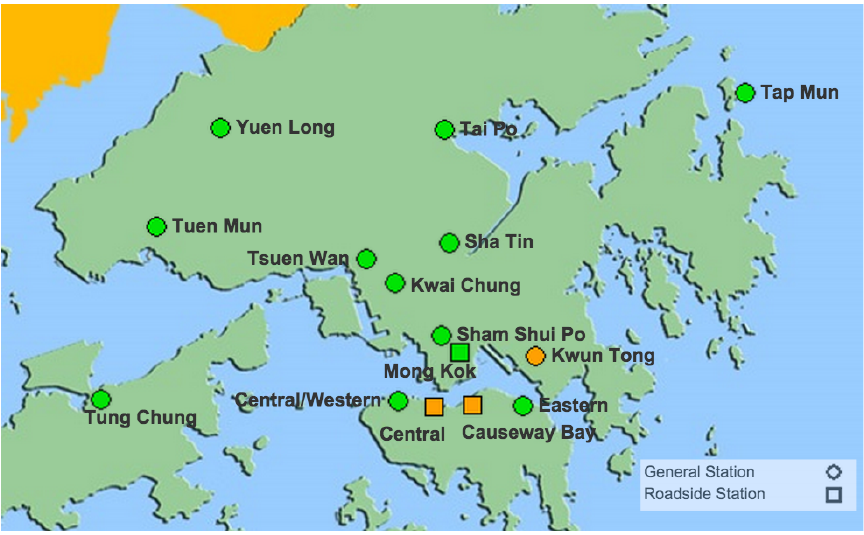
Figure 1. Deployment of stationary monitors in Hong Kong [6]. Table 1. The number of stationary monitors in selected